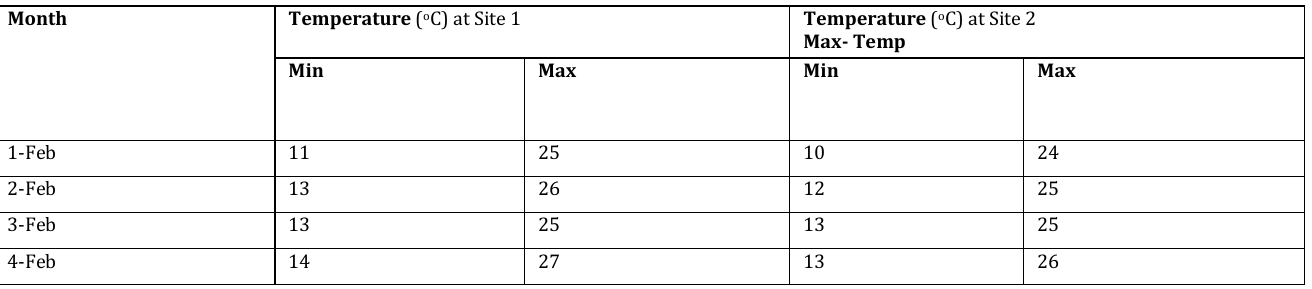
Table 1: Day time temperature in Site-2 Gata Walla